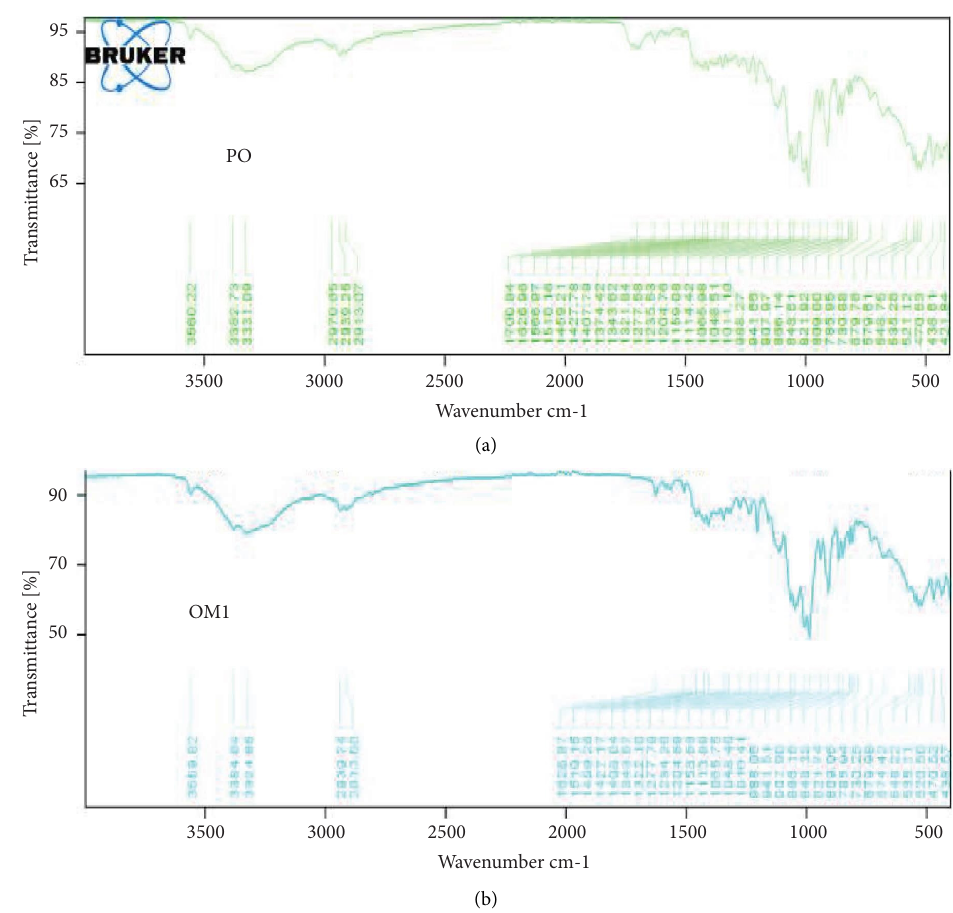
Figure 1: FTIR spectra of (a) pure omeprazole (PO) and (b)